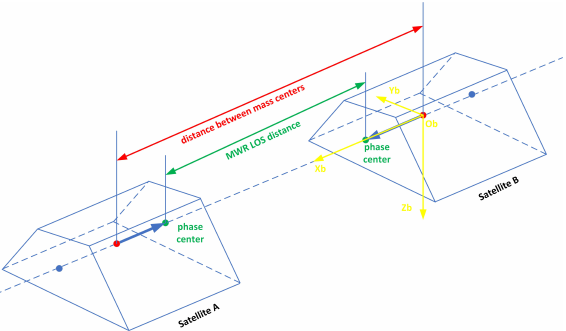
Figure 1. The geometry of LOS distance between leader-follower satellite antenna centers and distance between mass centers (ideal situation).